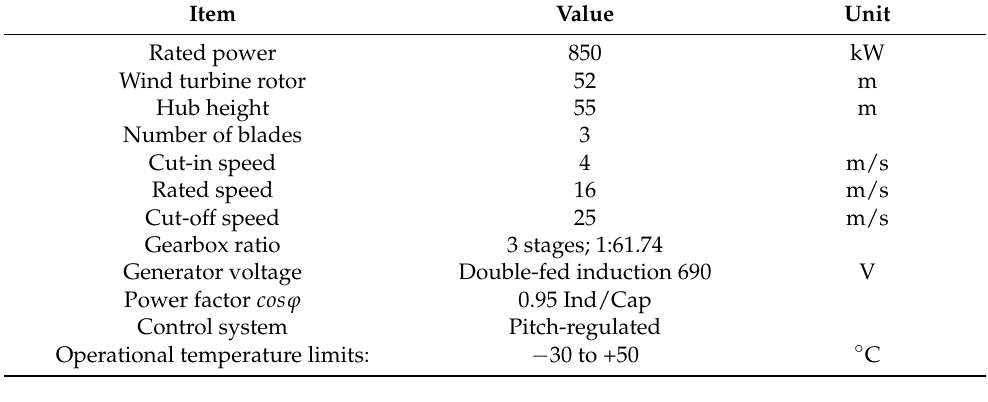
Figure 16. Pilot wind farm of 10.2 MW in Kabertene. Table 17. Technical data of Gamesa G52-850 [102]. Table 17. Technical data of Gamesa G52-850 [102].